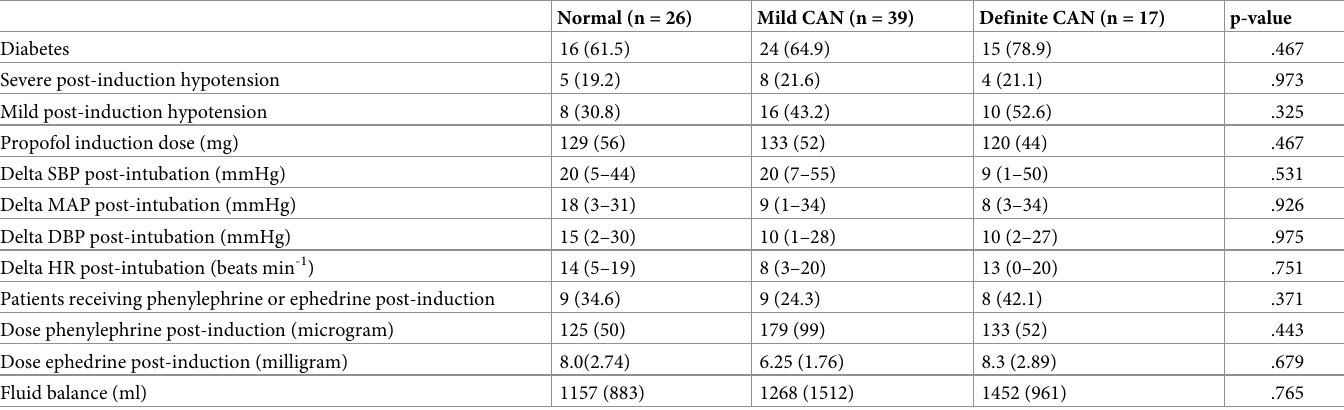
Table 2. Univariate analysis association CAN and post-induction haemodynamic